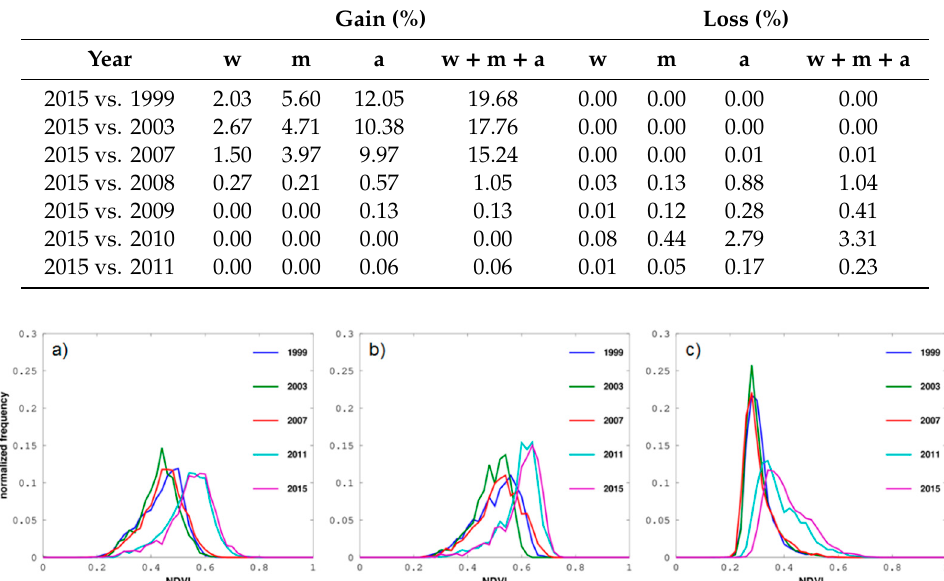
Table 4. Relative changes in vegetation cover for the time series 1999–2015 in woodland (w), Mediterranean macchia (m), and abandoned crops and pastures (a). The relative increase ( gain ) and decrease ( loss ) in vegetation cover was expressed as a percentage (%) by comparing the surface reflectance (SR) Landsat images of 2015 with those of the years 1999, 2003, 2007, and 2011, respectively. Gain (%)